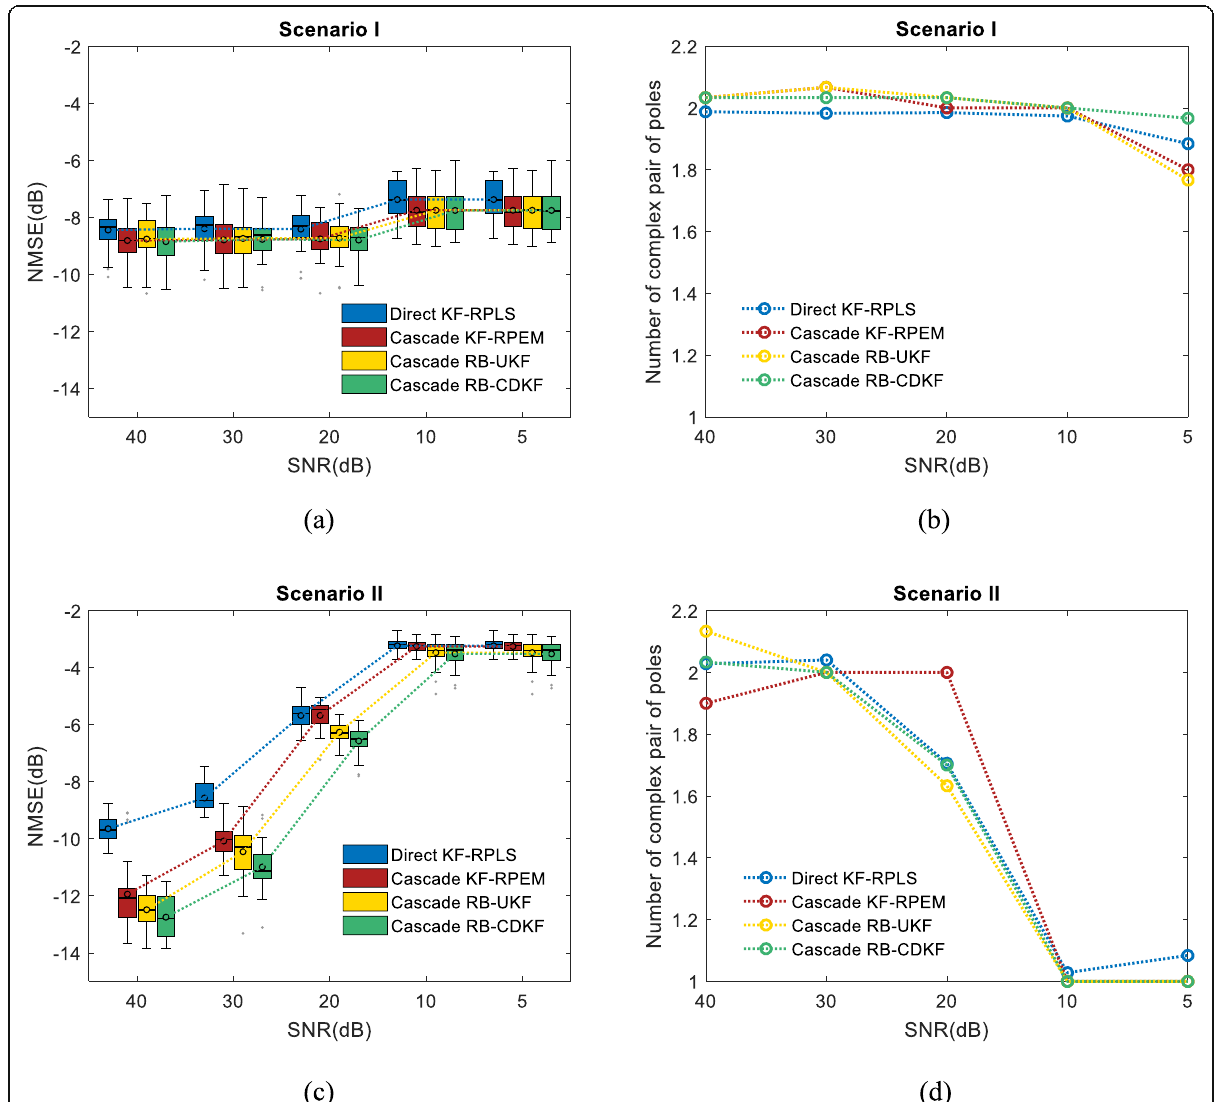
Fig. 5 NMSE (dB) boxplots (left panel, a , c ) and number of complex pair of poles selected by the GA (right panel, b , d ) for Scenario I (upper panel) and Scenario II (bottom panel). Blue, red, yellow, and green boxplots/curves refer to direct-form models estimated by KF-RPLS and cascade-form models estimated by KF-RPEM, RB-UKF, and RB-CDKF,